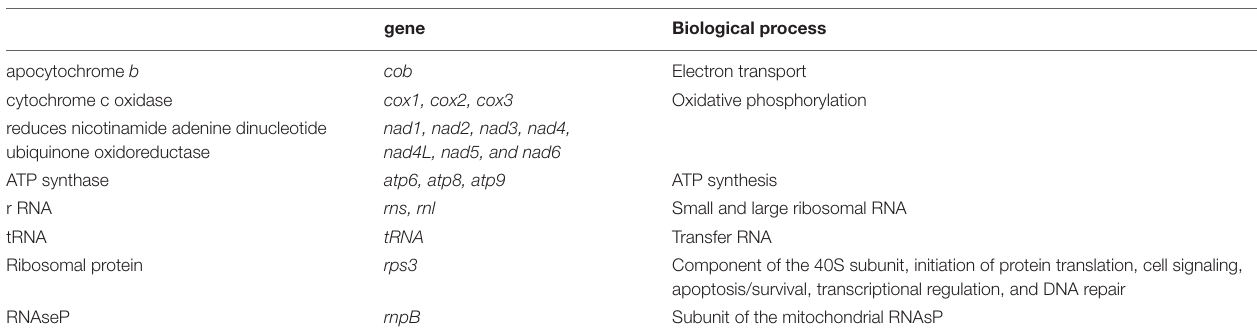
TABLE 1 | Conserved genes encoded in the fungal